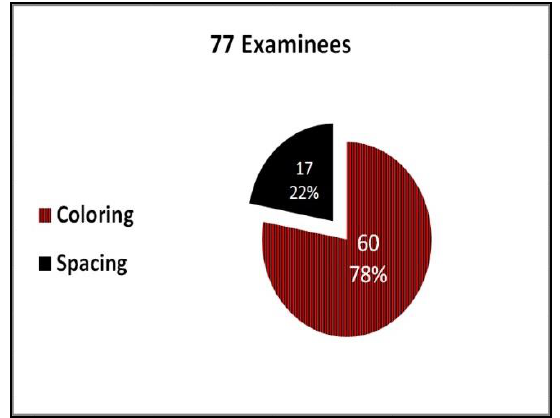
Figure 7. Preferences of identification way